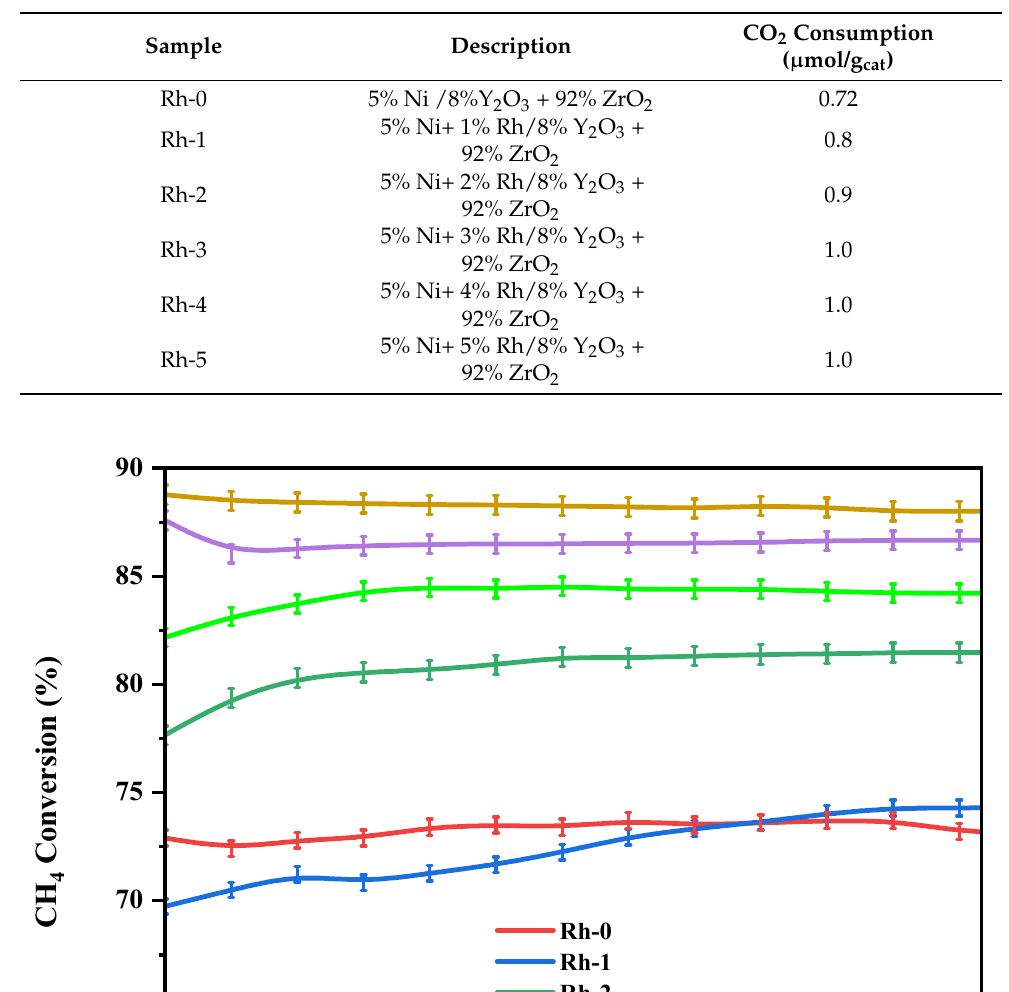
Figure 6. CO 2 conversion versus TOS for the Ni-Rh-x (x = 0, 1, 2, 3, 4, 5 wt.%) catalysts operated at 800 °C.